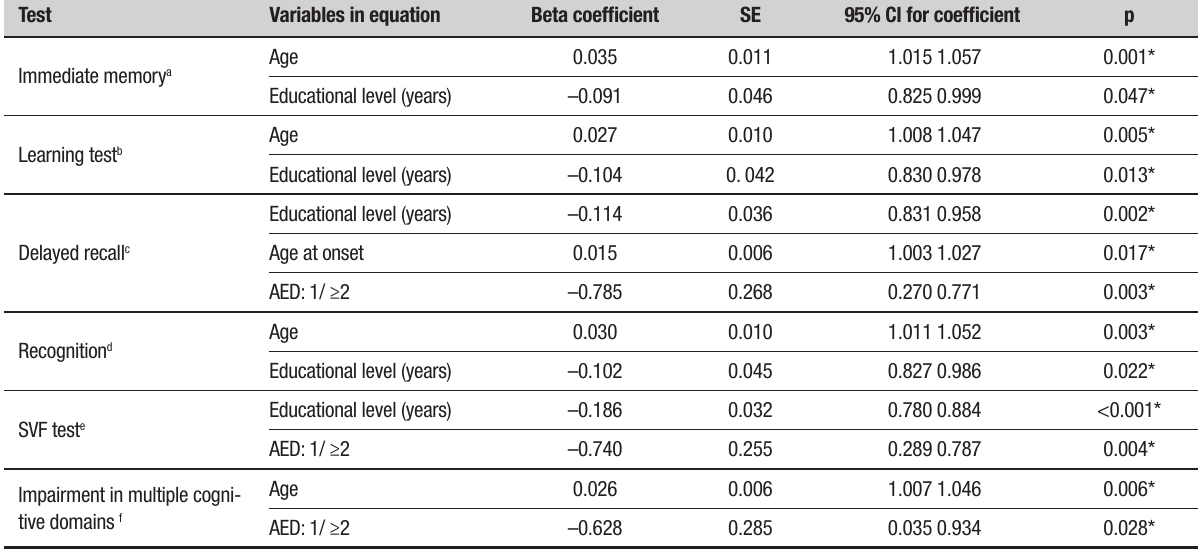
Table 5. Odds ratio for factors associated with poorer cognitive performance in 371